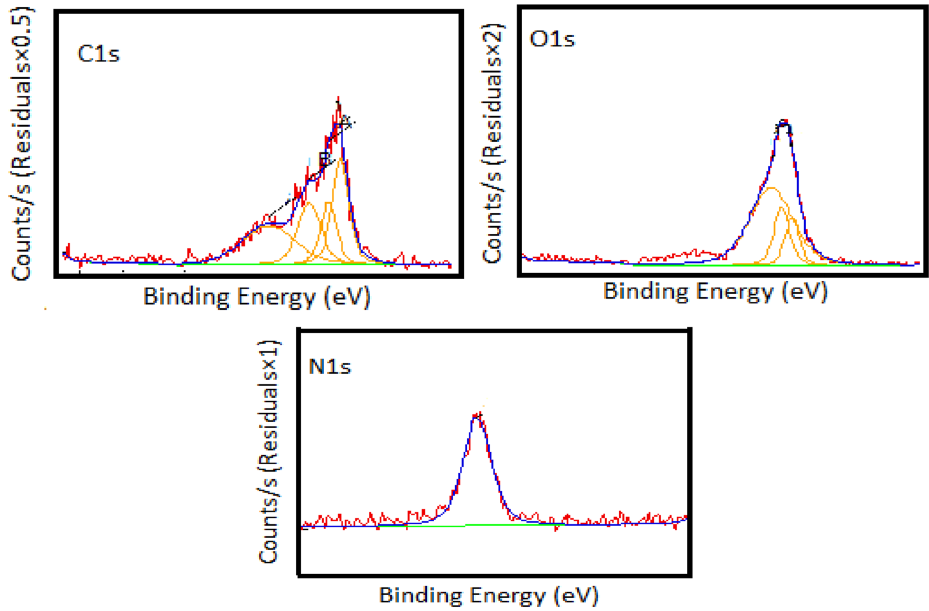
Figure 12. EDX analysis of PVA: CNPs: TLE after PM